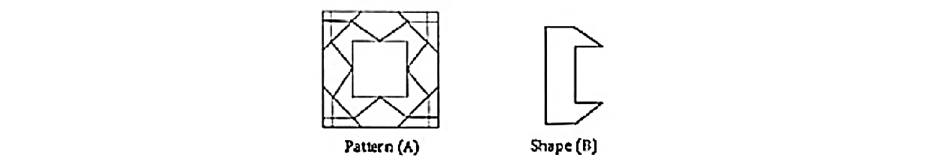
Figure A2. Sample item from the Logical Thinking test..